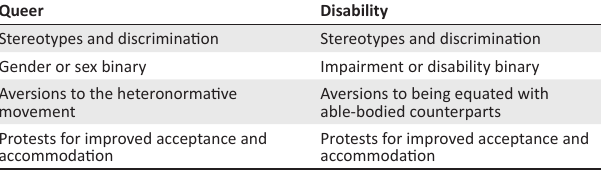
TABLE 1: Similarities between sexuality and disability stances and theories. Queer Disability Stereotypes and discrimination Stereotypes and discrimination Gender or sex binary Impairment or disability binary Aversions to the heteronormative Aversions to being equated with movement able-bodied